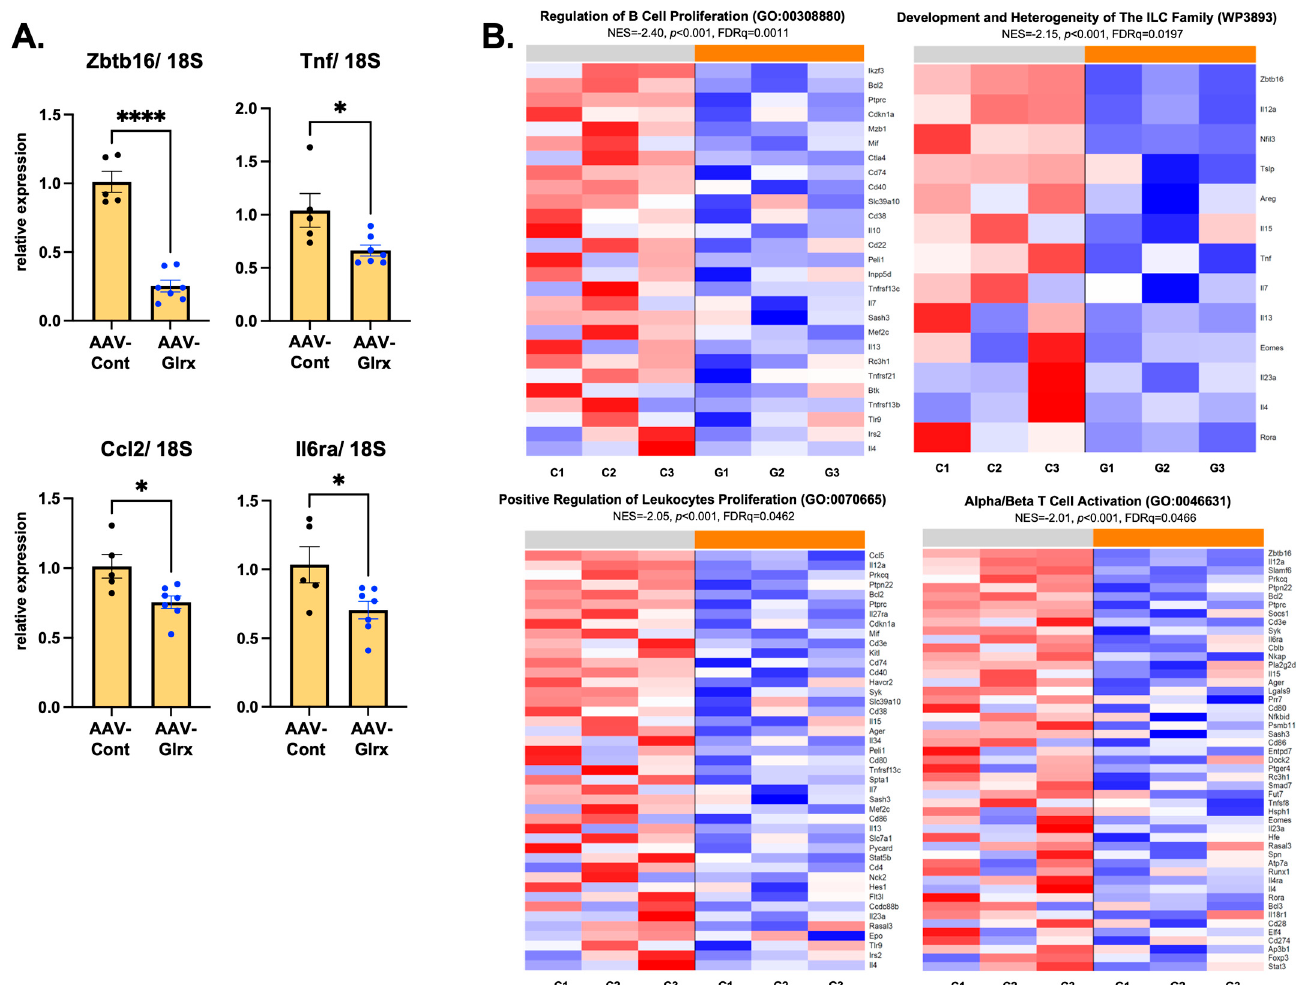
Figure 7. AAV-Hep-Glrx effects on transcriptome on diet-induced NASH liver. ( A ). Quantitative qPCR of livers of NASH-diet-fed mice treated with AAV-Hep-Glrx or AAV-Hep-control. Zbtb16: zinc finger and BTB domain-containing 16, Tnf: tumor necrosis factor-alpha, Ccl2: CC motif chemokine ligand 2, Il6ra: IL–6 receptor alpha. Blue dots on the graph indicate mice treated with AAV-Hep-Glrx. * p < 0.05, **** p < 0.0001. Error bars indicate standard error. ( B ). Heatmaps of the leading edges of immune-related gene sets with significant coordinate downregulation (FDR q < 0.25) in response to AAV-Hep-Glrx administration. Rows correspond to genes, and columns correspond to samples (C1–C3: mice treated with AAV-Hep-control; G1–G3: mice treated with AAV-Hep-Glrx). Blue and red indicate expression values at least 2 standard deviations below or above the mean (white) of each row, respectively. Genes are arranged in descending order from top to bottom by the magnitude of the moderated t